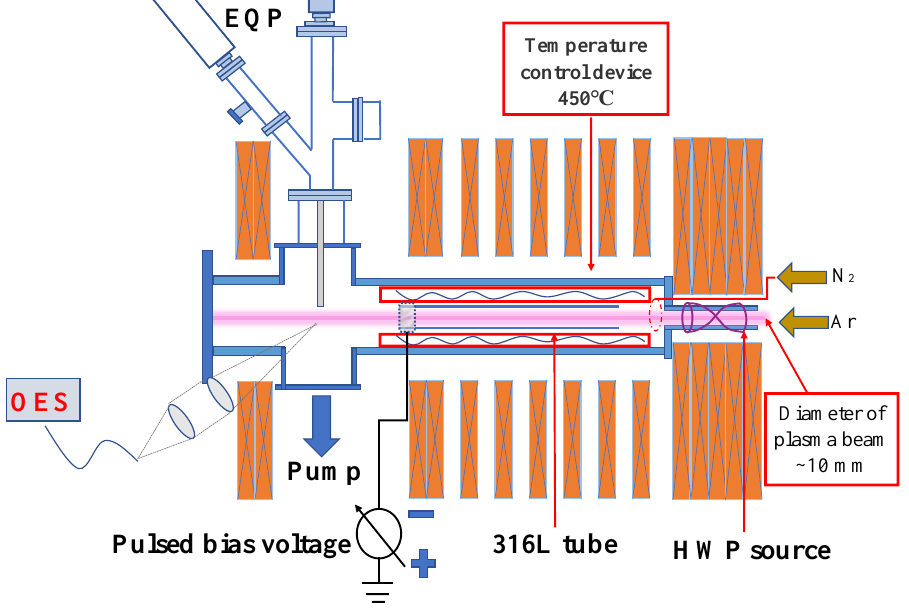
Figure 1. Schematic of the helicon plasma system.